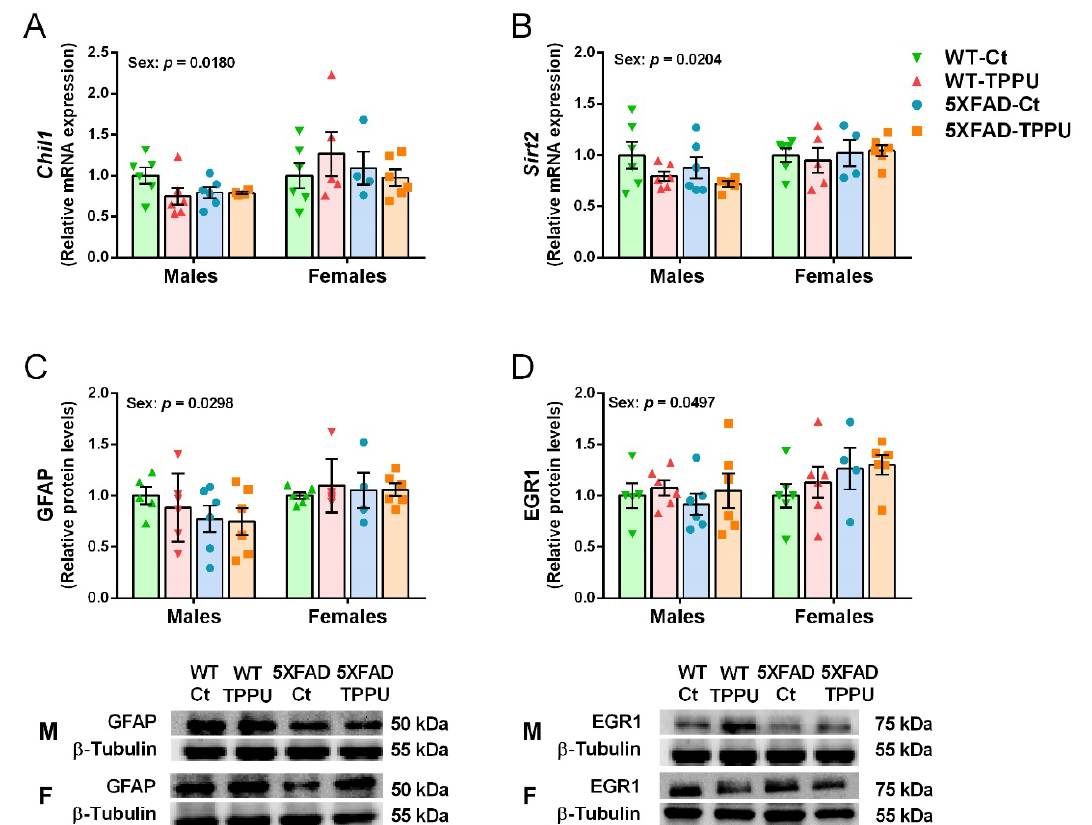
Figure 7. Differential neurodegenerative markers in male and female 5XFAD mice. Expression levels of the genes Chil1 ( A ) and Sirt2 ( B ). Relative protein levels of glial fibrillary acidic protein (GFAP) ( C ) and early growth response 1 protein (EGR1) ( D ). Representative blots for males (M) and females (F) are shown below the corresponding histograms in ( C , D ). ( A , B ) Hippocampus samples; ( C , D ) cerebral cortex samples. Values are mean ± SEM (( A – D ) n = 4–6). Statistics: ANOVA, effect of sex in ( A – D ), p values of the significant factor are indicated in the corresponding graphs. The Bonferroni post-hoc test was not significant in the comparison between specific experimental groups of males and females.